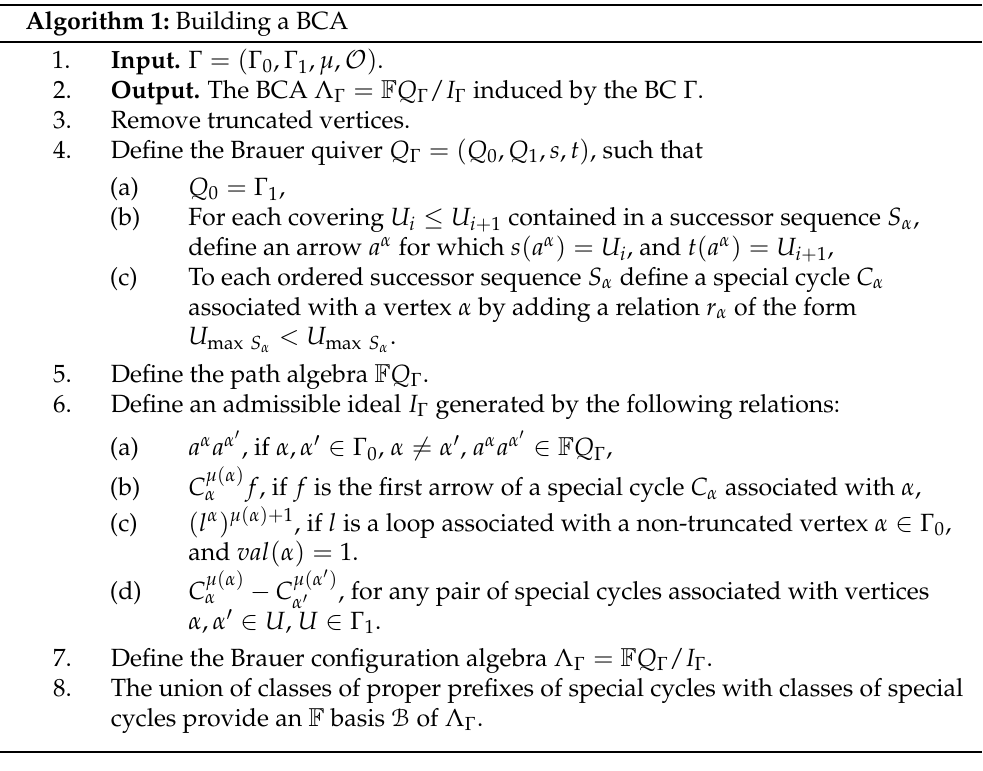
Algorithm 1 is a short version of an algorithm introduced in [6] by Cañadas et al. to construct a Brauer configuration